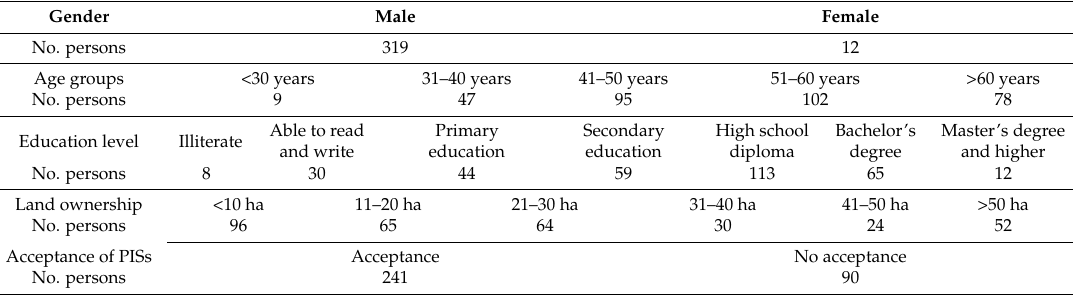
Table 3. The societal status of the statistical sample of the research.